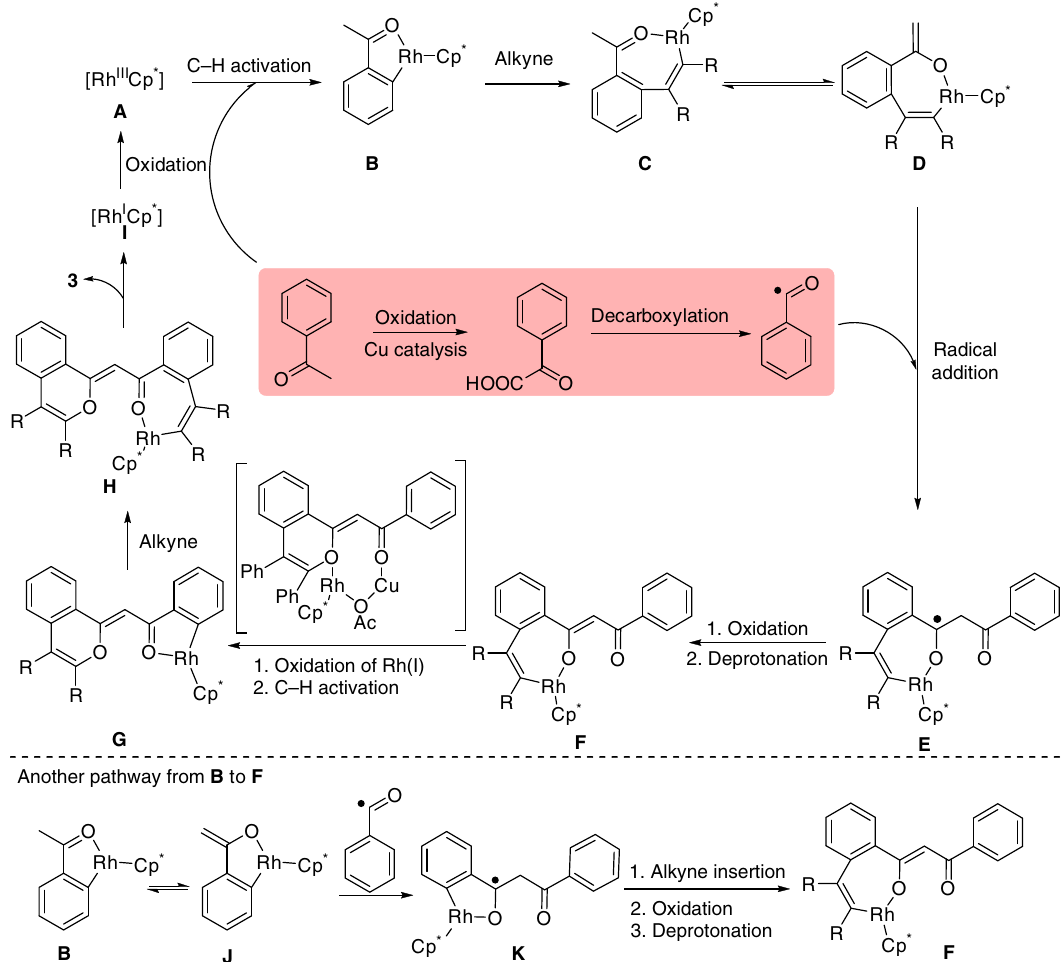
Fig. 7 Plausible catalytic cycle. The possible mechanism involves the Rh-catalyzed C2 – H activation of aryl ketone to generate the rhadocycle and the Cu- catalyzed oxidation/C – C bond cleavage of aryl ketone to produce the acyl